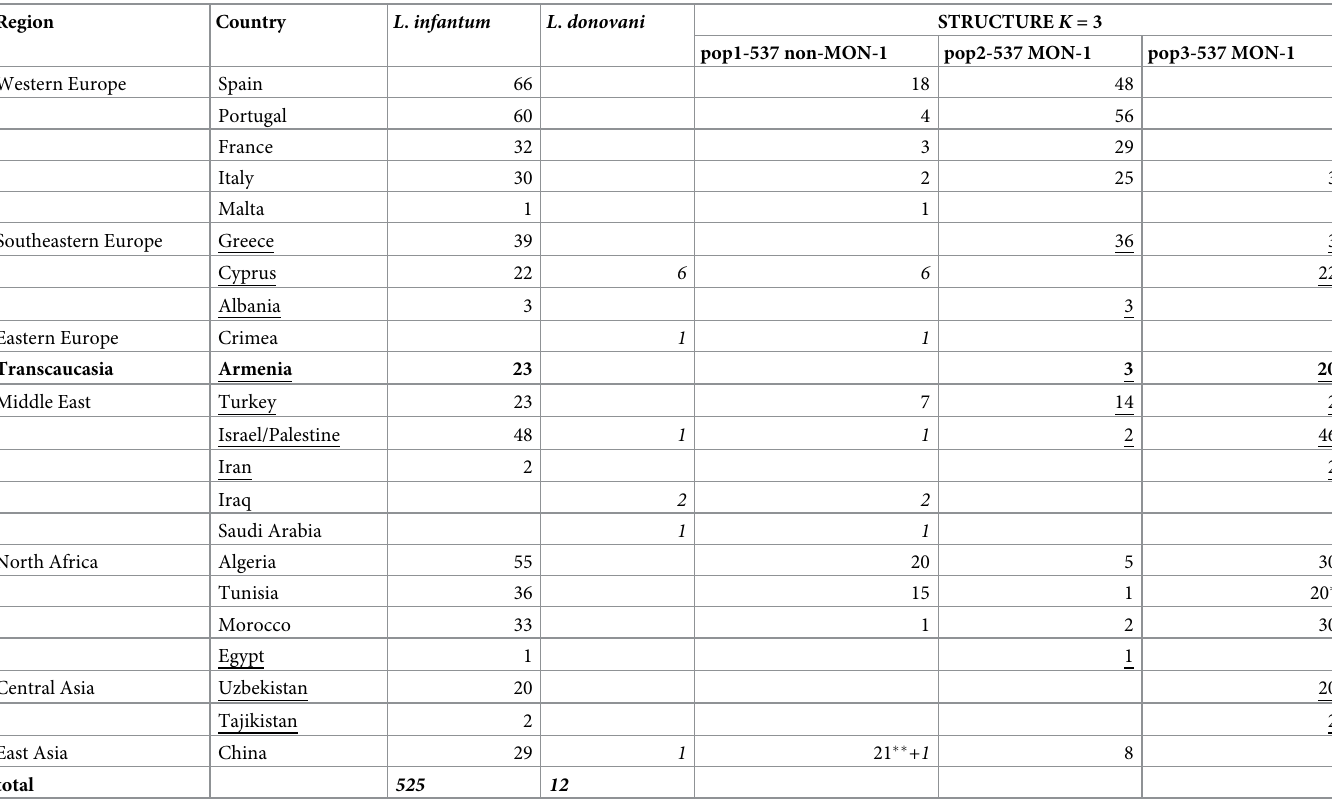
Table 2. Overview of the 537 strains included in the global MLMT analysis and assignment to the three main populations inferred by STRUCTURE. Region Country